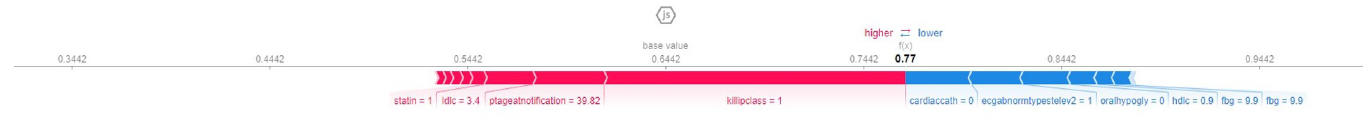
Fig 5. SHAP force plot.